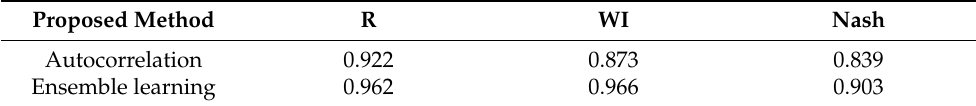
Table 4. Evaluation criteria for forecast models.